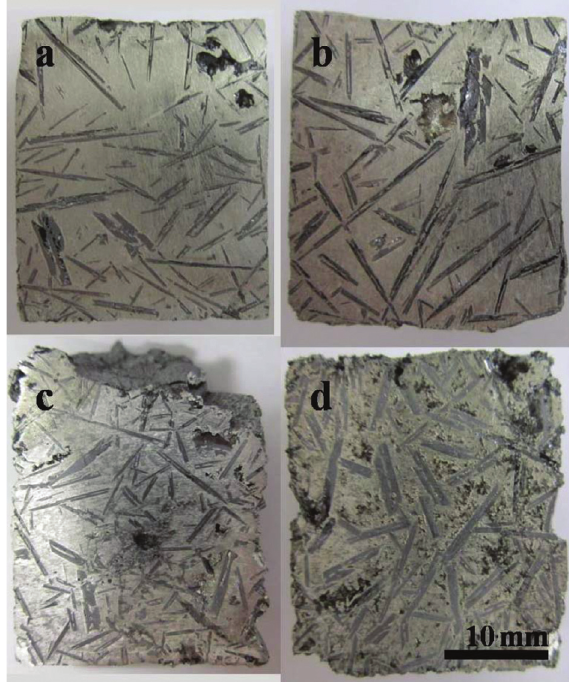
Figure 4: Macrostructures of Al – Si alloy with different Ga contents: (a) Al – 30%Si,(b) Al – 30%Si – 5%Ga, (c) Al – 30%Si – 10%Ga, (d) Al – 30%Si – 20%Ga.